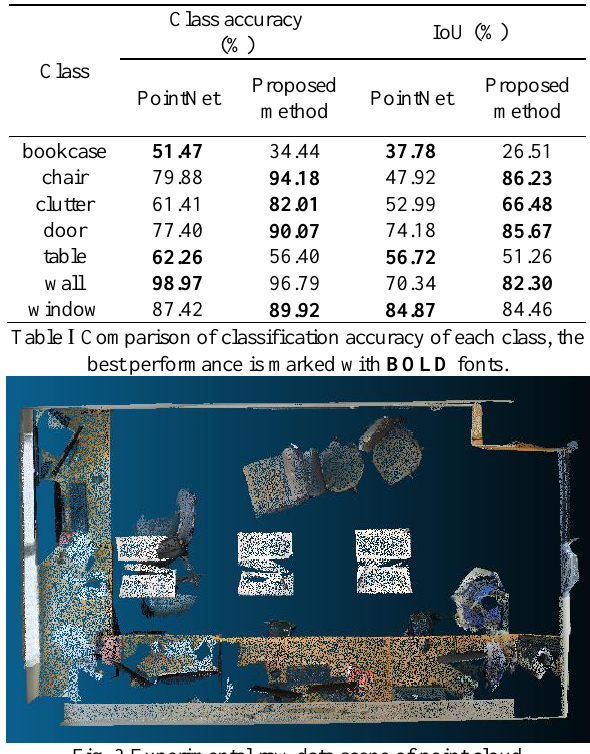
Fig. 3 Experimental raw data scene of point cloud